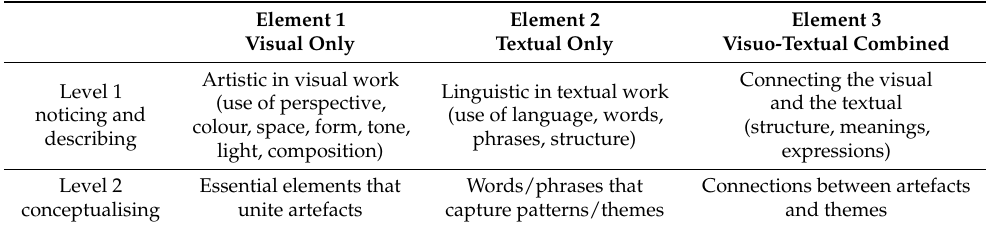
Table 2. Tabular introduction to levels and elements of interpretation within the Systematic Visuo- Textual Analysis [64].